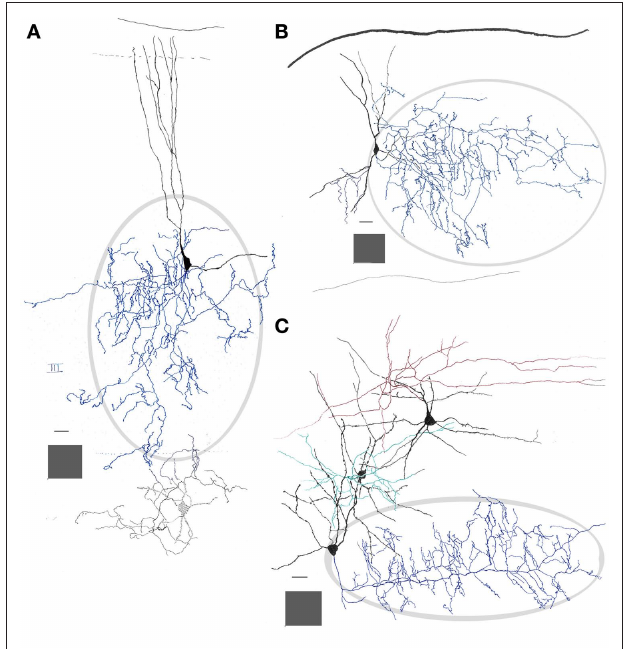
Figure 3 | interneurons in the adult mouse piriform cortex. (A) Dendrites (black) ascend to resolve in sublayer Ia (dashed). The axon field (blue, encircled) distributes in layers II and III. (B) Chandelier cell whose axon (blue) is polarized anteriorly. (C) Interfascicular neuron with an axon (red) that distributes in layer I, and two interneurons in layer II, a fusiform middle, and a chandelier cell with axons directed radially and rostrally (green and blue, respectively). Adult mouse brain, rapid-Golgi technique. Calibration bars = 20 μm; squared areas = 250 μm 2 .